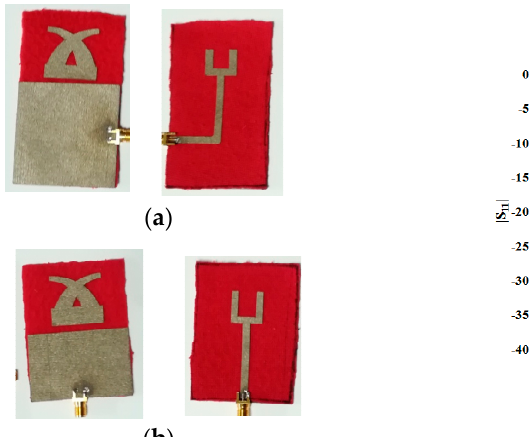
Table 3. Geometrical parameters of the 2-bit prototype shown in Figure 8a.